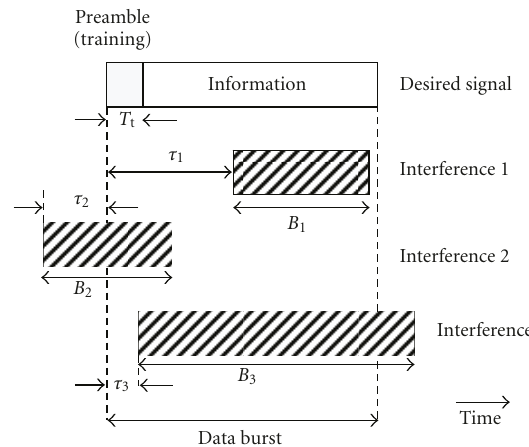
Figure 6: Asynchronous interference